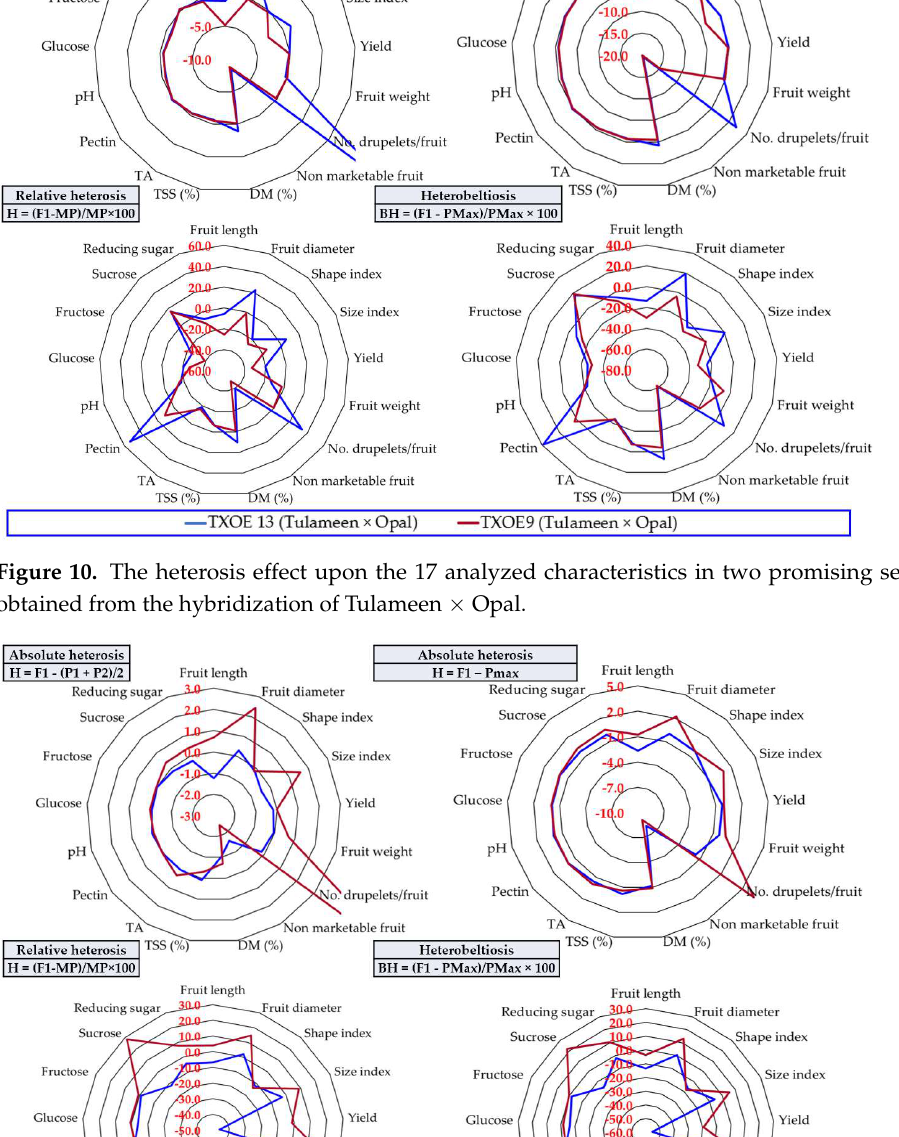
Figure 9. The heterosis effect upon the 17 analyzed characteristics in two promising selections ob- tained from the hybridization of Tulameen × Pathfinder.